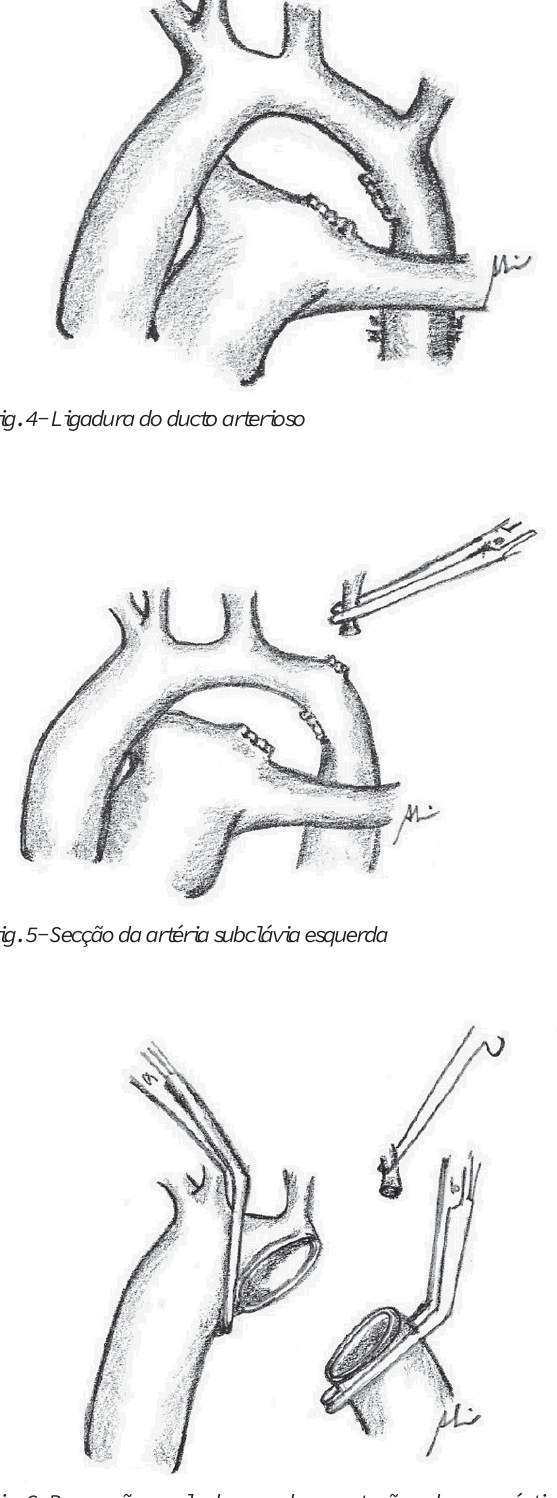
Fig. 6- Ressecção ampla da zona de coarctação e do arco aórtico